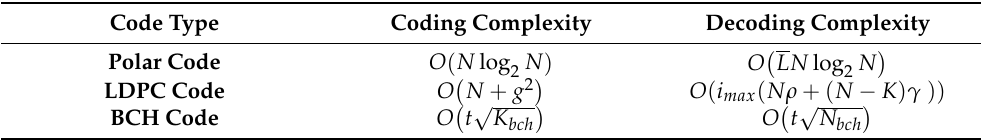
Table 7. Comparison of computational complexity of coding and decoding of Polar, LDPC, and BCH